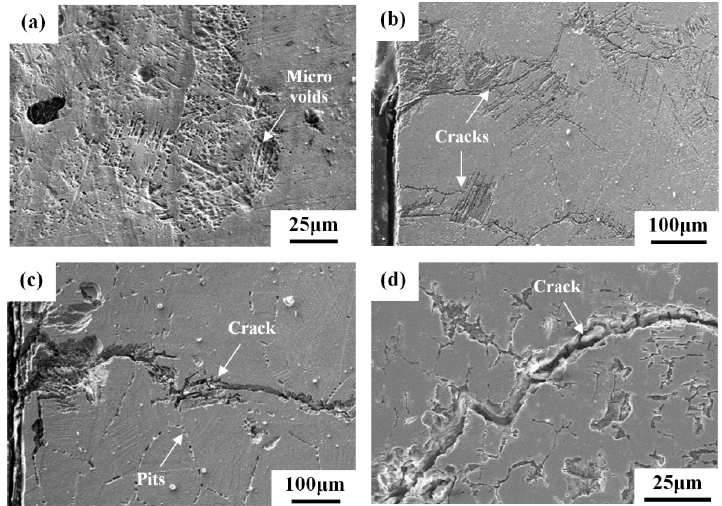
Figure 8. SEM micrographs showing the surface morphologies of U-bend specimens: ( a ) 304L-BM; ( b ) 304L-CR; ( c ) 304L-CRS; and ( d ) 308L-CRS specimens.